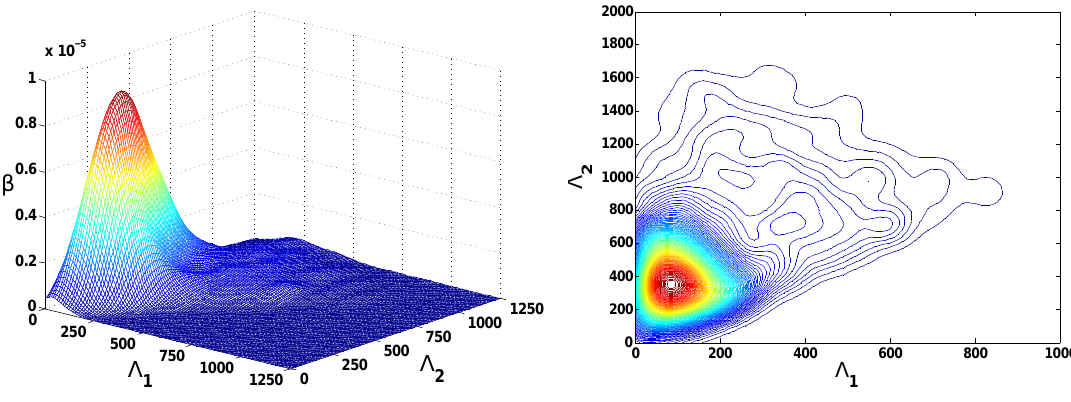
Figure 3. The PDF reconstructed with Λ 1 – Λ 2 data for GW170817 from the LIGO website [39] as a 3D graphics ( left panel) and as a contour plot ( right